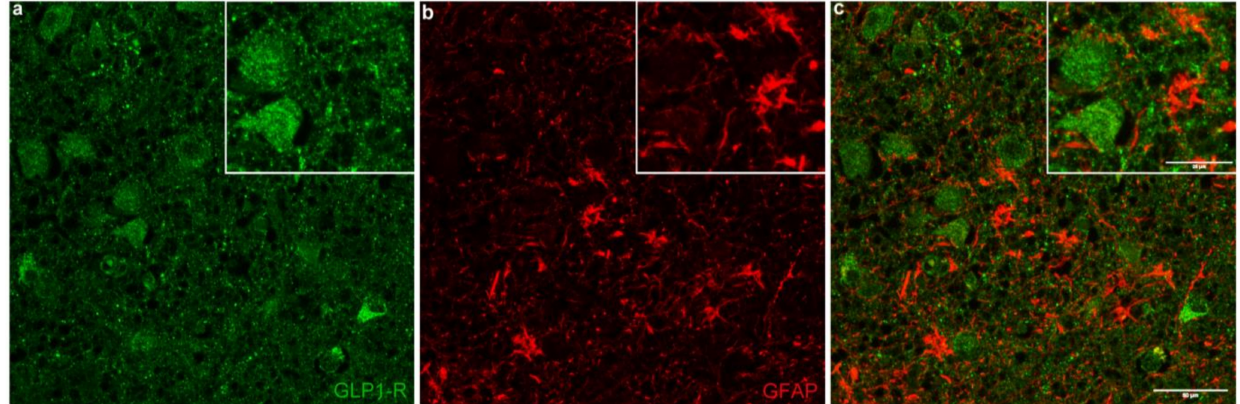
Figure 5. Confocal image showing GLP-1R and GFAP double immunofluorescence labeling in human hypothalamus. Panel ( a ) shows GLP-1R-immunoreactivity (green) and panel ( b ) displays GFAP- immunoreactivity (red). The merged image ( c ) shows the lack of colocalization of GLP-1R and GFAP. Scale bar equals 50 µ m (25 µ m in